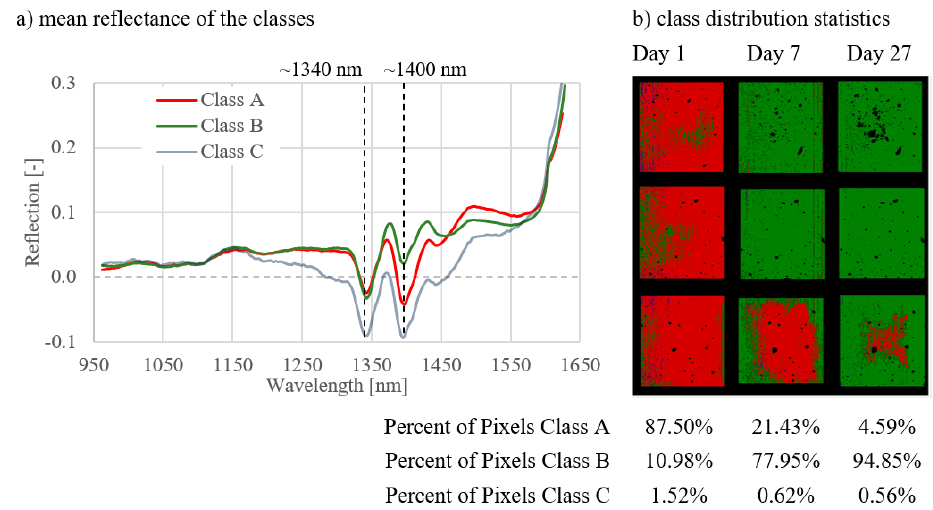
Figure 9. Results for combination 5; comparison of the measurement days of NB2 samples.